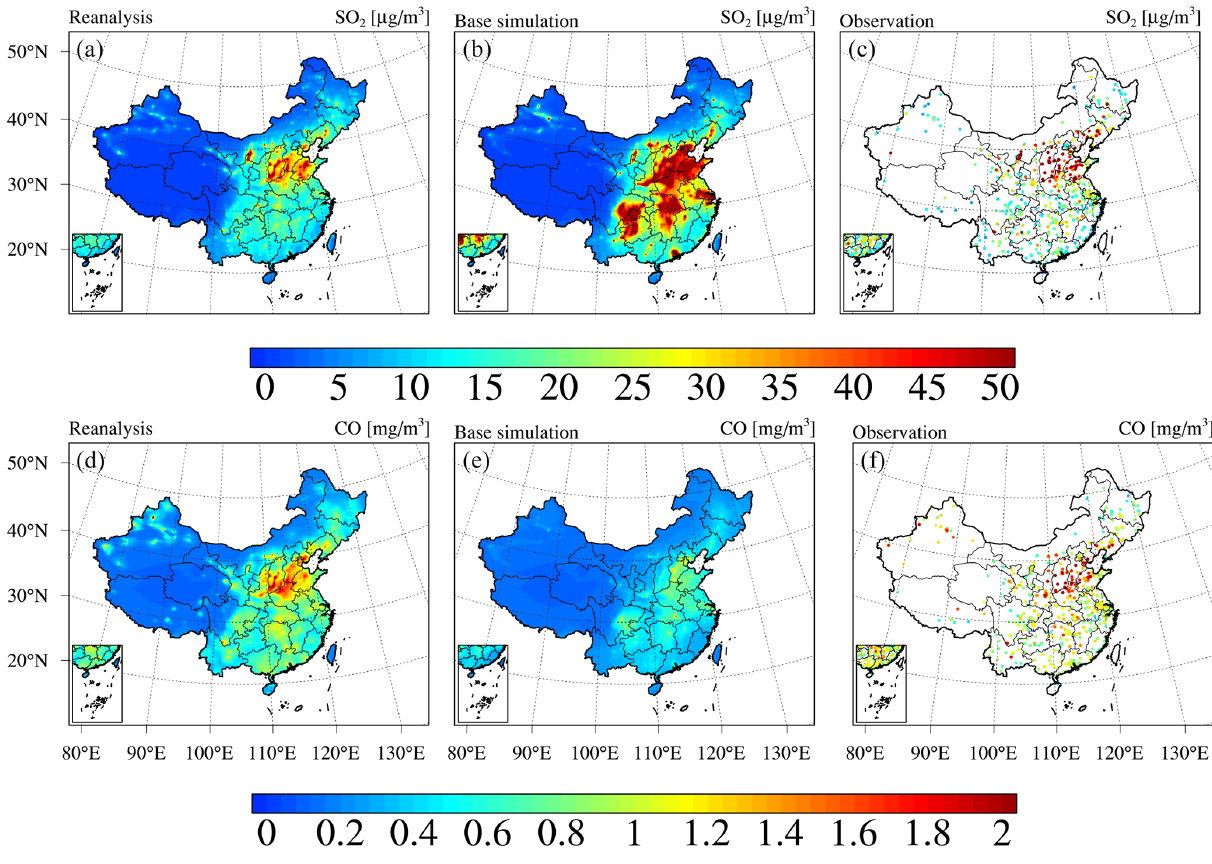
Figure 9. Same as Fig. 5 but for the SO 2 and CO